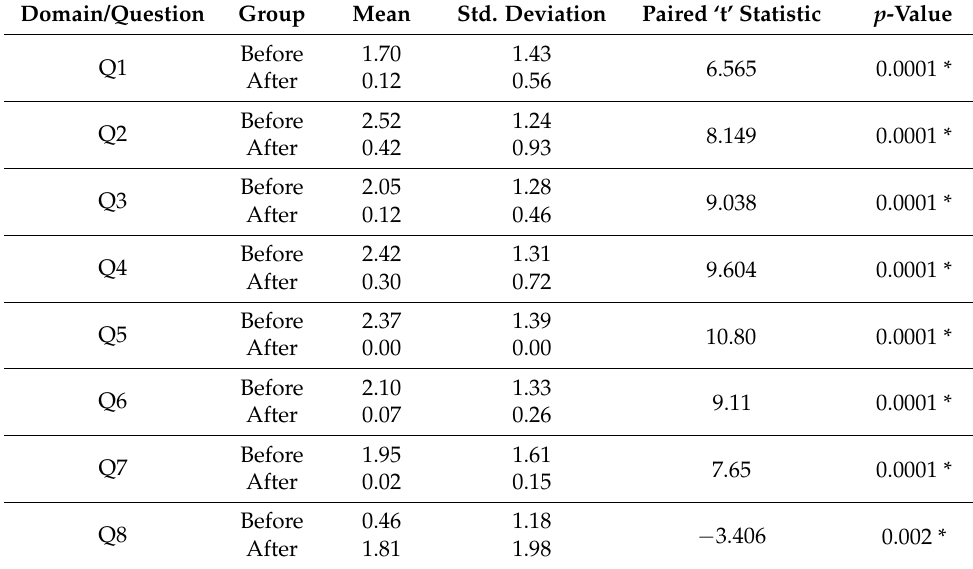
Table 3. Comparative evaluation of quality of life before and after treatment in Group 1—Modified